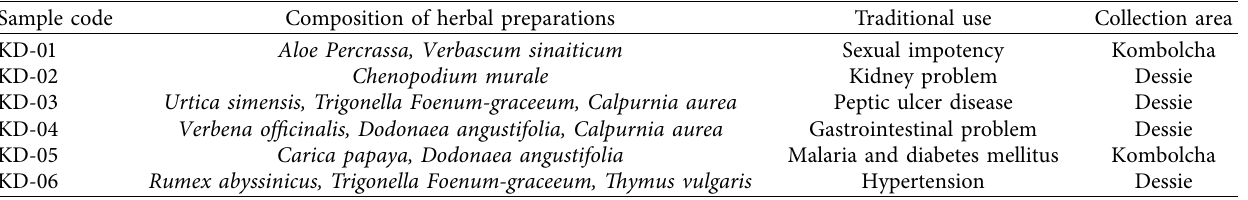
Table 1: List of traditional herbal preparations commonly used by the community of Dessie and Kombolcha town, Northeast Ethiopia. Sample code